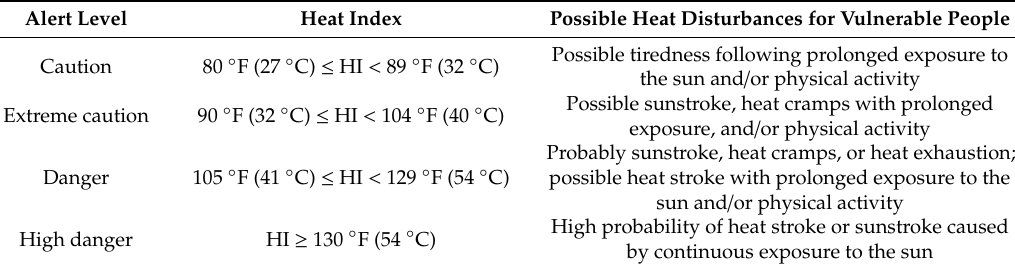
Possible tiredness following prolonged exposure to the sun and / or physical activity